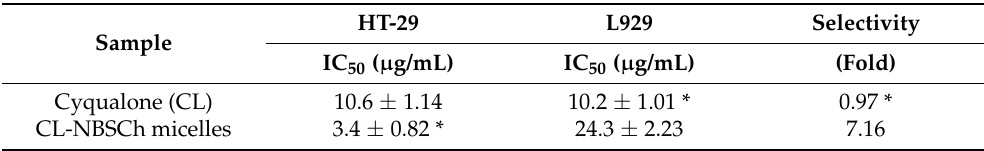
Figure 8. HT-29 ( a ) and L929 ( b ) cells’ viability (%) of the CL ( (cid:4) ), CL micelle ( (cid:4) ) and blank micelle ( (cid:4) ) by MTT assay. Table 3. Cytotoxicity and selectivity of free cyqualone (CL) and CL-loaded NBSCh micelles against HT-29 human colon cancer cells and L929 mouse fibroblasts cell